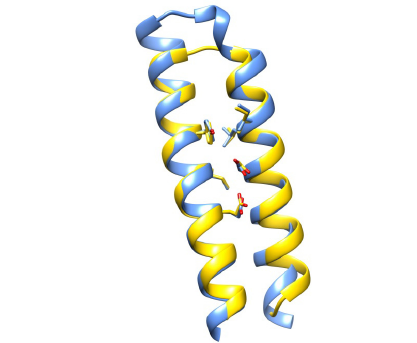
Figure 6. The protein chain with the largest fraction of covered residues, 1jm0-A (yellow), supported by a common chain, 3ogh-A (blue). The residues covered by RSMs stabilize the central part of the helix-helix